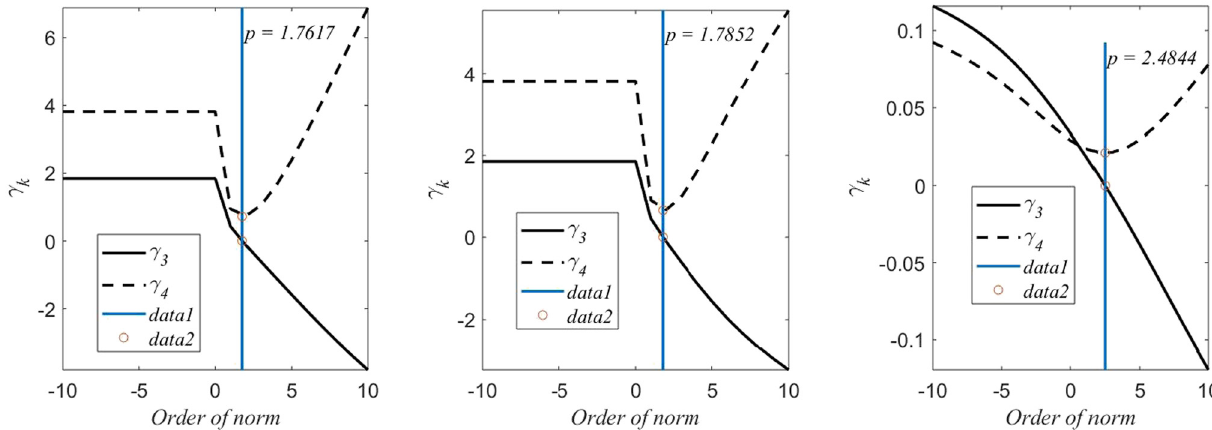
Figure 4: Analysis of parameters for the new con fi rmed cases in